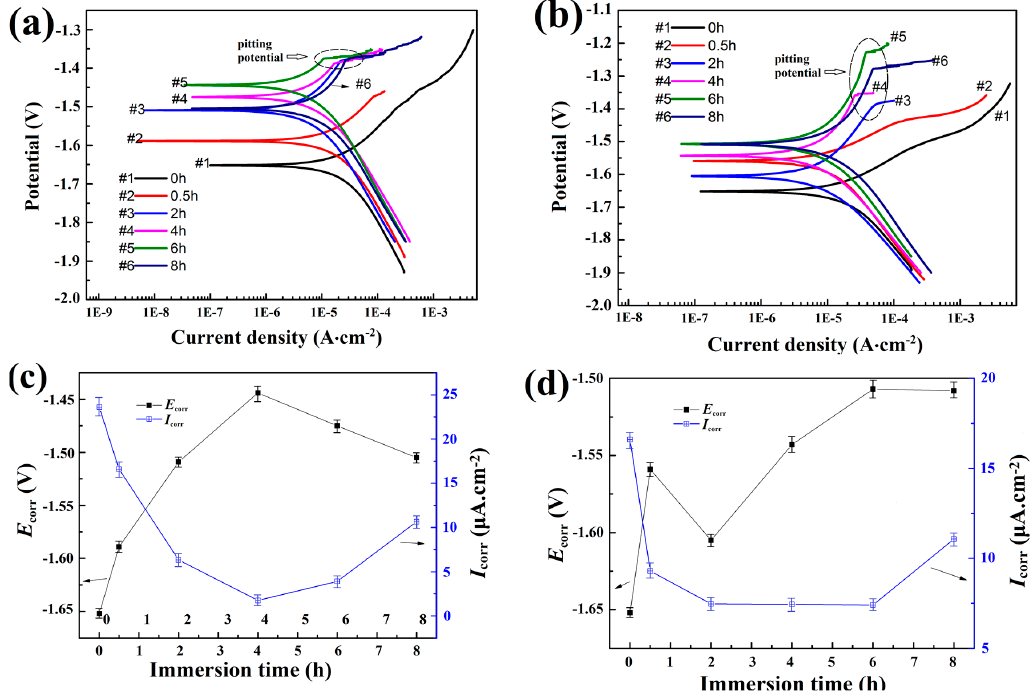
Figure 7. Potentio-dynamic polarization (PDP) curves and related parameters of the Mg-9Li alloys tested at different exposure time. ( a ) and ( c ) are the pdp curves and the evolution of E corr and I corr values of the cast alloy. ( b ) and ( d ) are the pdp curves and the evolution of E corr and I corr values of the cast alloy.